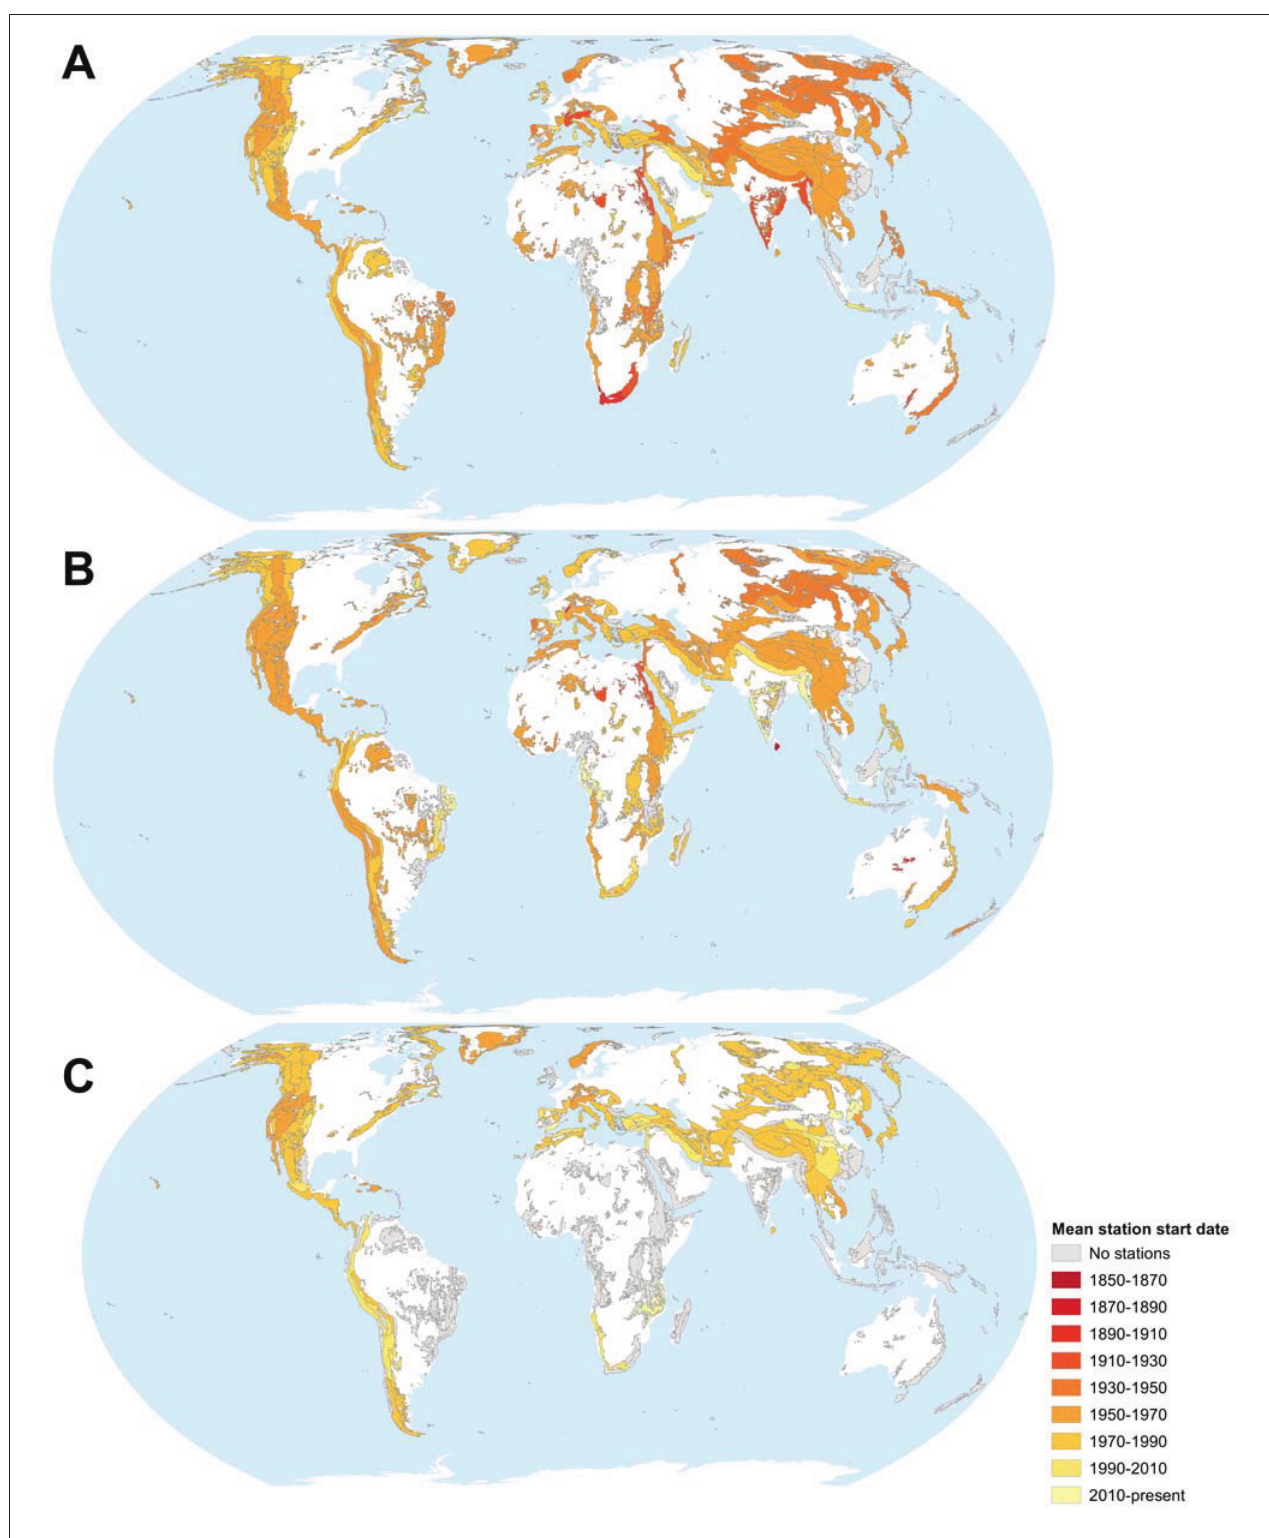
FIGURE 5 | Mean record start date of GHCNd stations in mountainous terrain for PRCP (A) , TMAX (B) , and SNWD (C) by GMBA mountain polygon. The corresponding plot for TMIN is provided in the online Supplementary Material. Whilst the entire GMBA regions are shown, the statistics plotted correspond to only the mountainous parts of these regions, as delineated by Kapos et al.